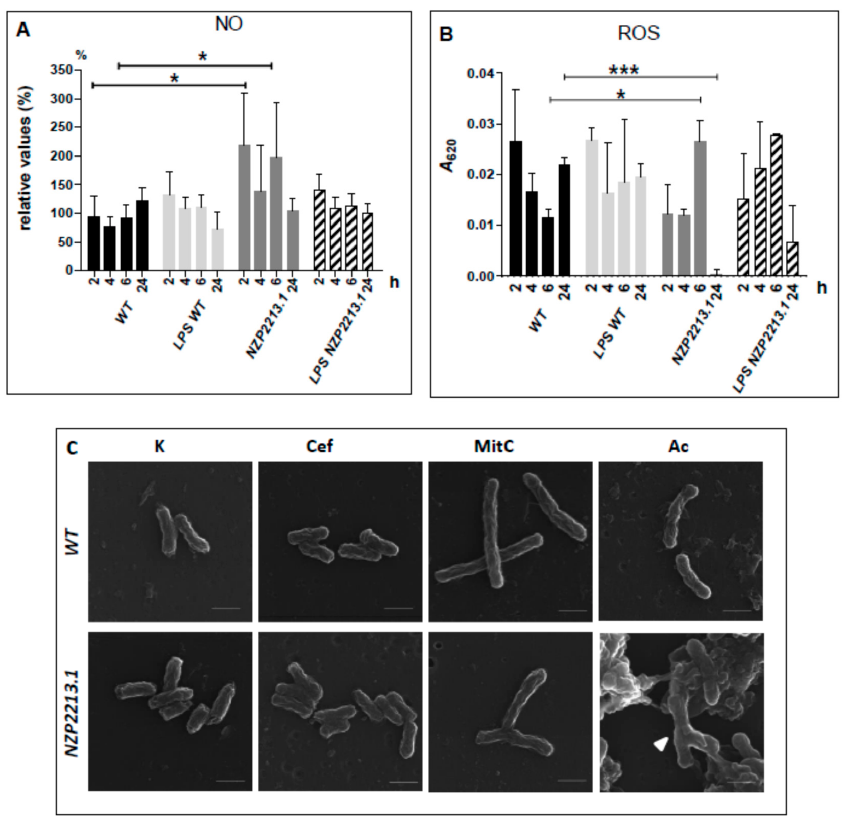
Figure 7. Summary of bactericidal mechanisms used by A. castellanii against M. loti . Graphs show